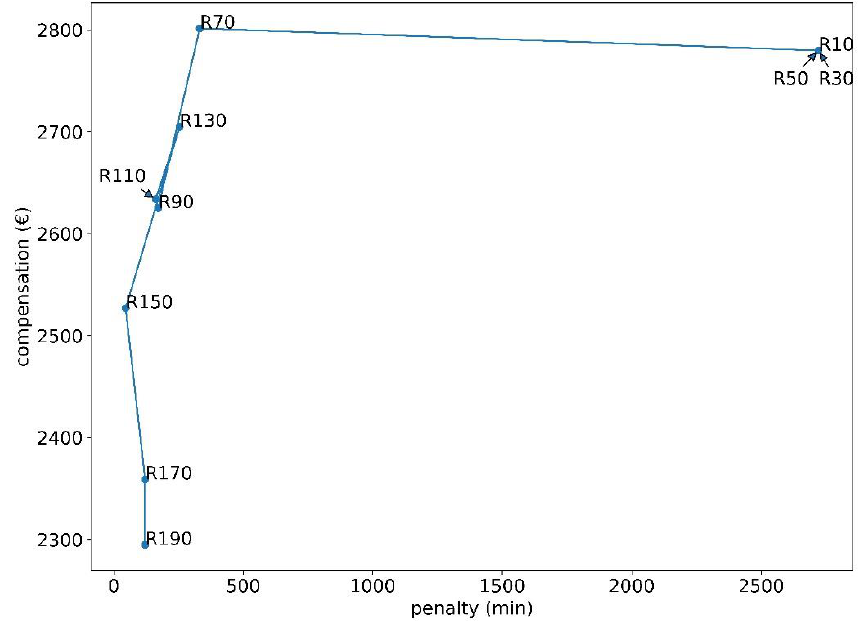
Figure 12. Compensation versus penalty min . The dots show the result of running the experiment with different values of reputation factor . Each dot is labeled with the corresponding value of reputation factor.